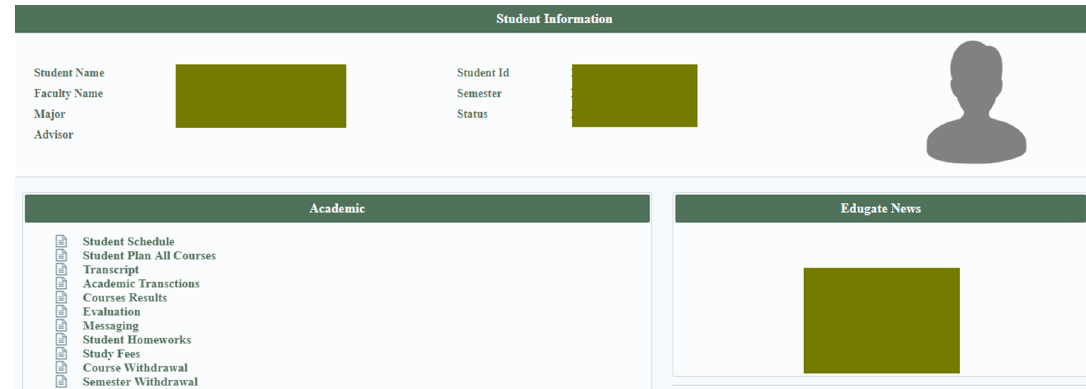
Figure 4. The structure of EAR—Example 3.